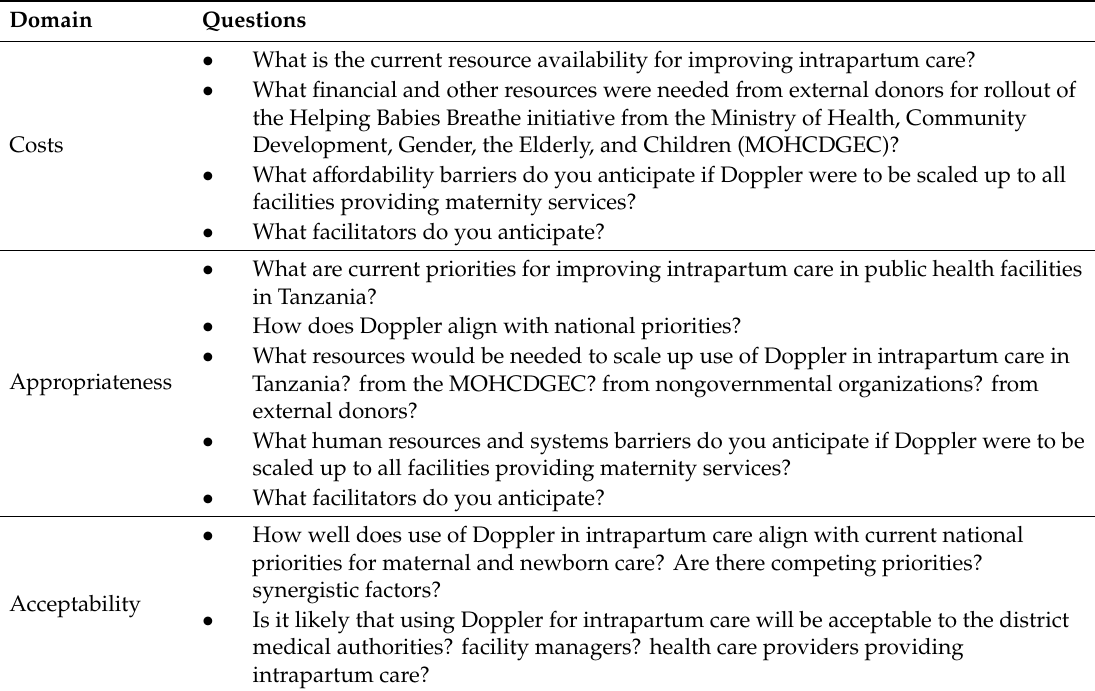
Table 2. Domains for scale-up of Doppler for intermittent fetal heart rate monitoring in